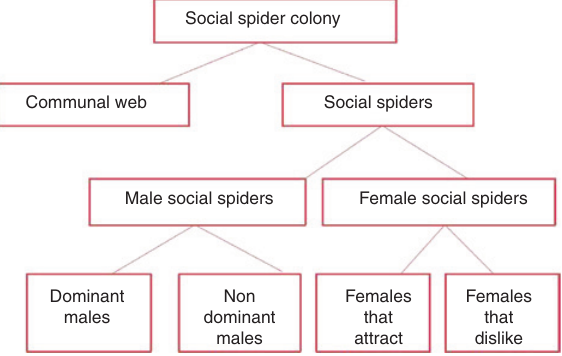
Figure 1: Elements of a Social Spider Colony.